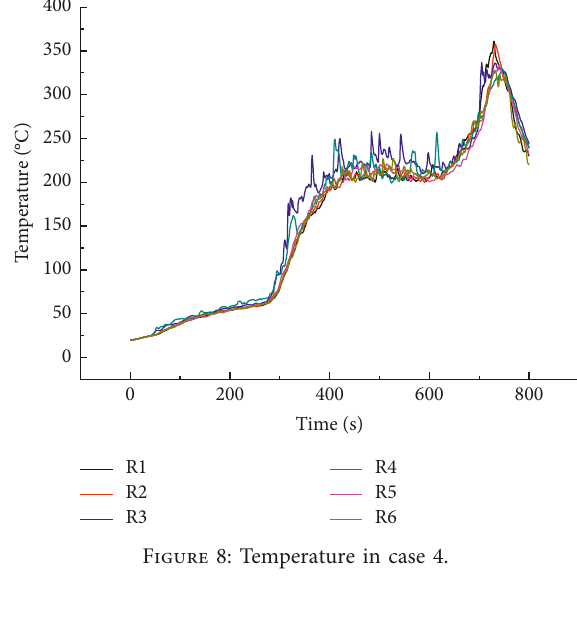
Figure 6: Temperature in case 3.